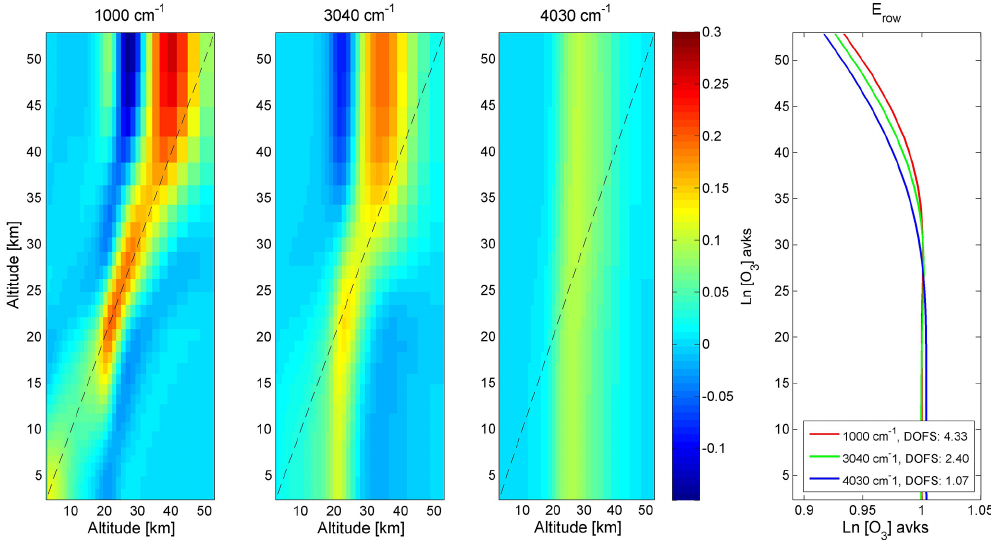
Figure 3. FTIR O 3 averaging kernel matrix, avks, for the three analysed spectral regions, expressed as ln [ O 3 ] , for typical measurement conditions of Izaña spectrometer 120 / 5HR (25 October 2010). The dotted lines are the diagonals ( x = y ). The panel on the right hand side shows the total sensitivity of FTIR system ( 6 row ) and the DOFS (degrees of freedom for signal).